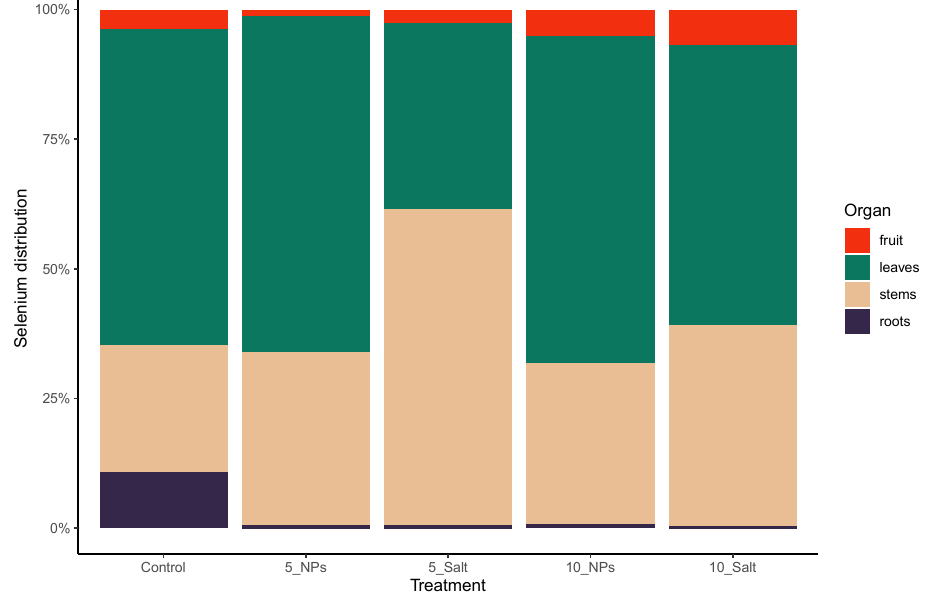
Figure A2. Percentage of distribution of accumulated Se in different tomato plant organs (cv. Micro- Tom) 53 DAT at 0, 5, and 10 mg Se L − 1 as Se nanoparticles (NPs) and sodium selenate (salt).